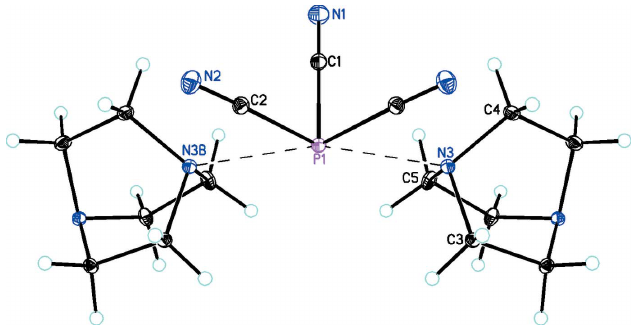
Figure 1 Diagram showing the square-pyramidal coordination sphere of the P atom in 1 . Interactions with the C 6 H 12 N 2 units are shown as dashed bonds. Atomic displacement parameters are at the 30% probability level. The symmetry operation to generate the complete P(CN) 3 unit is x , y , 1 and for the complete dabco molecule is x , 3